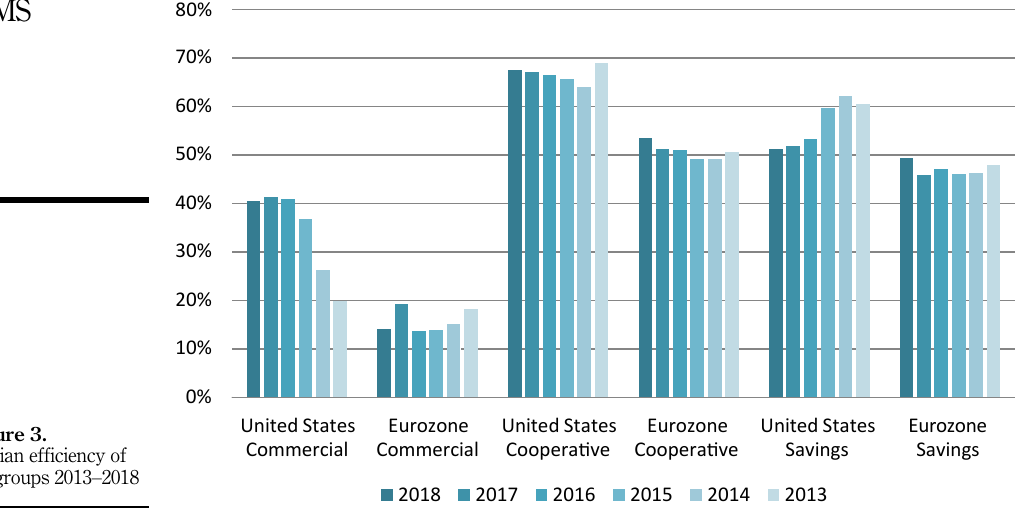
Figure 3. Median efficiency